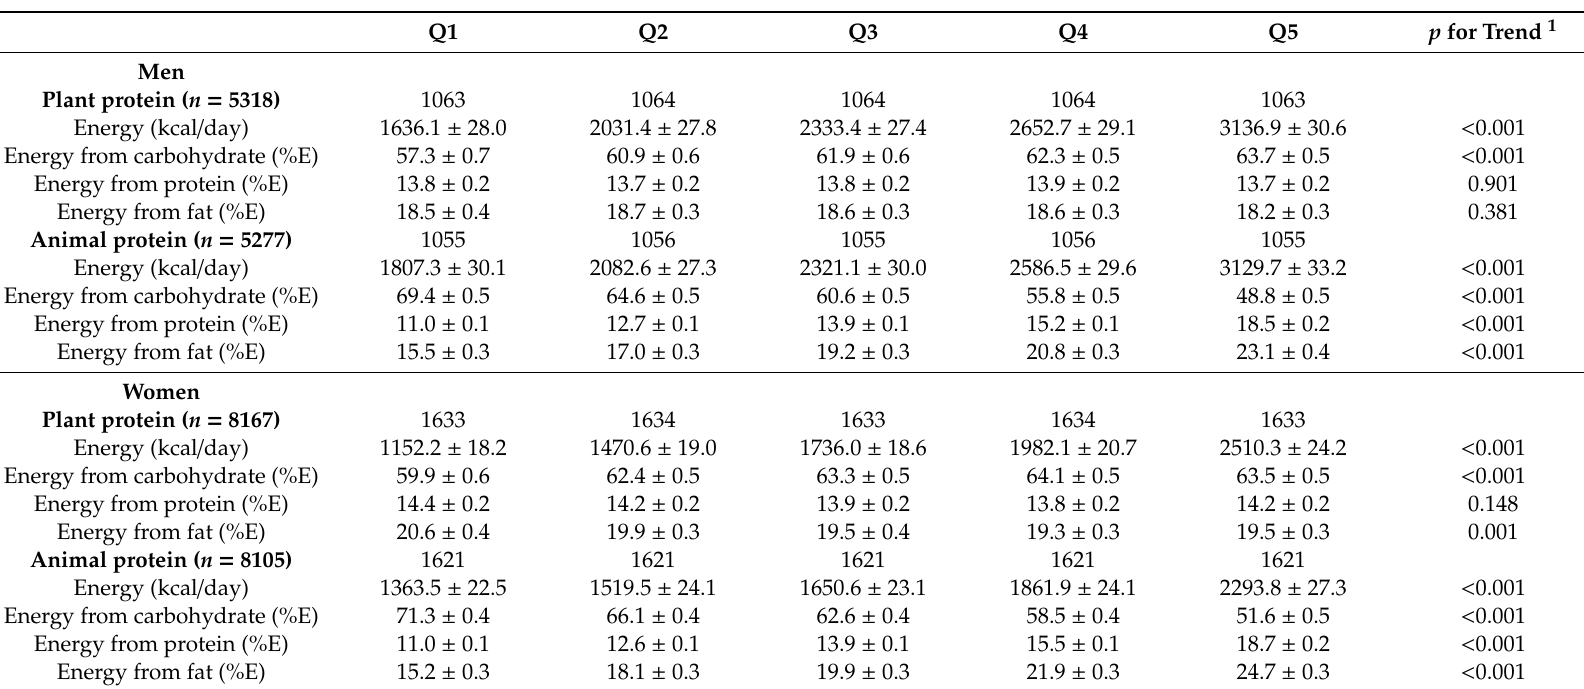
Table 3. Energy and nutrient intakes according to quintiles of plant and animal protein intake in Korean adults aged 30–64